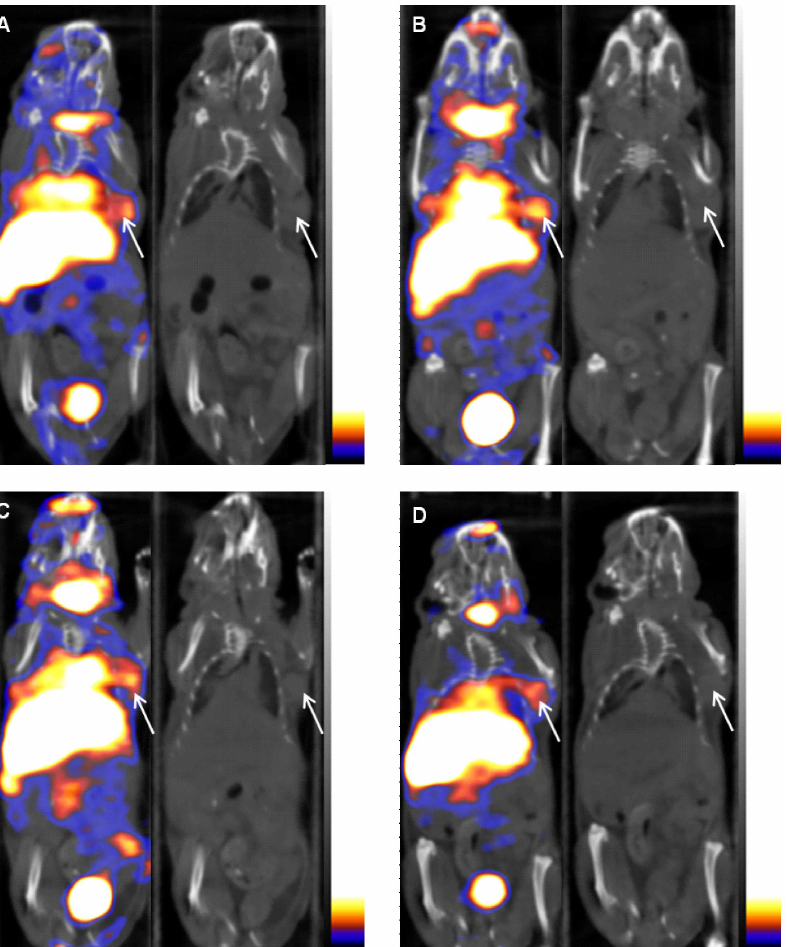
Figure 3. Small-animal SPECT/CT imaging in the insulinoma model. Small-animal SPECT/CT imaging after the injection of 125 I-liraglutide into the tail veins of nude mice indicated that the tumour could be clearly imaged at 30 min after this injection ( A ), with the clearest images of the tumour obtained at 90 min after the injection ( B ). The tumour had begun to fade by 180 min after the injection ( C ) and had significantly faded by 360 min after the injection ( D ). In addition, the thyroid, liver, heart, lung, kidney, bladder, and other organs were visible to various degrees in the imaging results. The CT coronal tomographic images correspond to the SPECT/CT images, and the arrow indicates the tumour location.